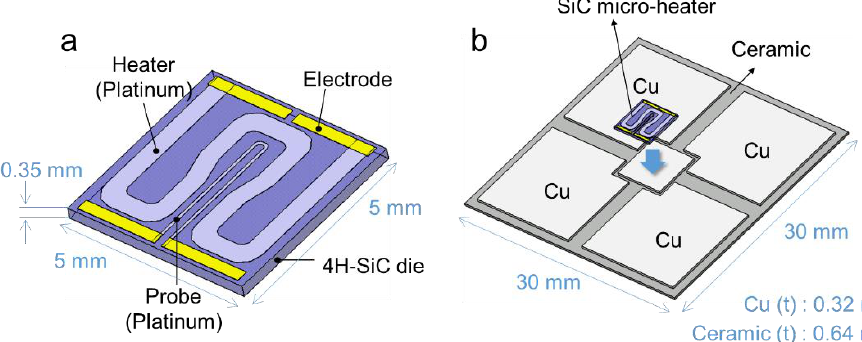
Figure 2. SiC heater die-attached structure: ( a ) SiC micro-heater chip structure ( b ) SiC heater chip on the substrate.